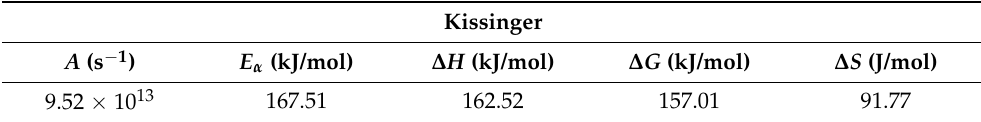
Figure 5. Kinetic parameter fitting curve under Kissinger method. Table 5. Kinetics and thermodynamics parameters value calculated by Kissinger method. (Derived based on the T p from five different heating rates).